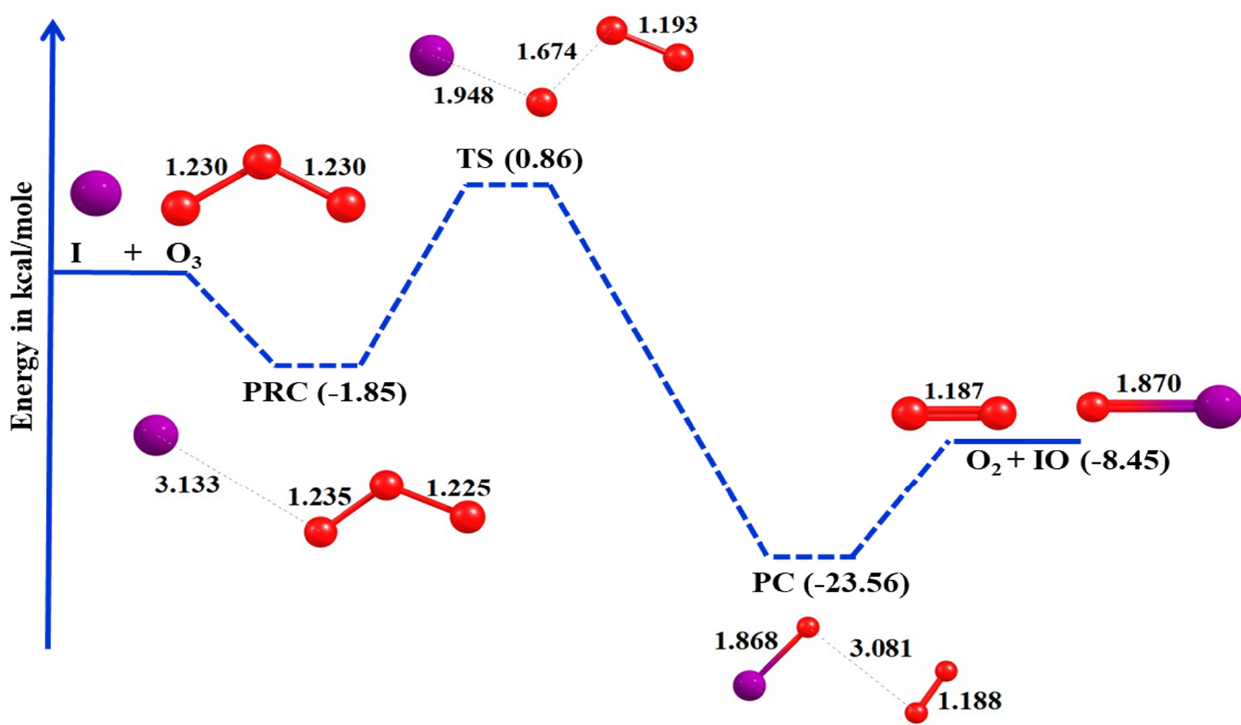
Figure 5. Potential energy level diagram for the reaction of O 3 with I obtained at the MRCI + Q/aug-ano-RCC- VTZP//MP2/aug-cc-pV(T + d)Z levels of theory.